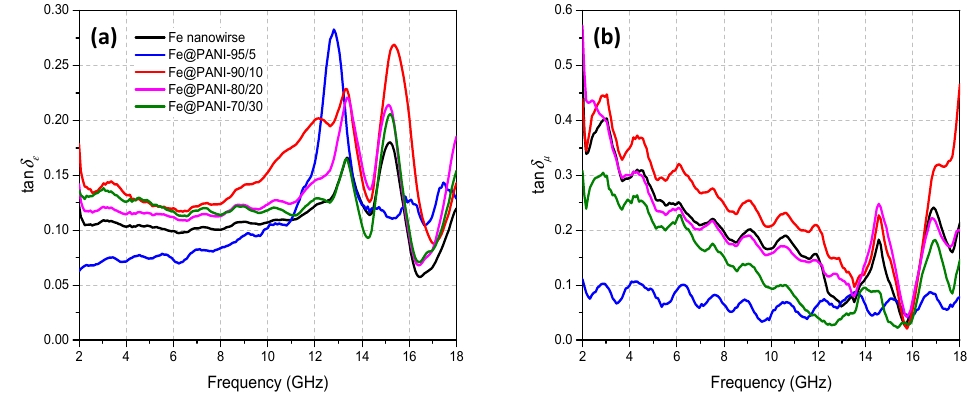
Figure 11. Loss tangent factors of ( a ) permittivity and ( b ) permeability.